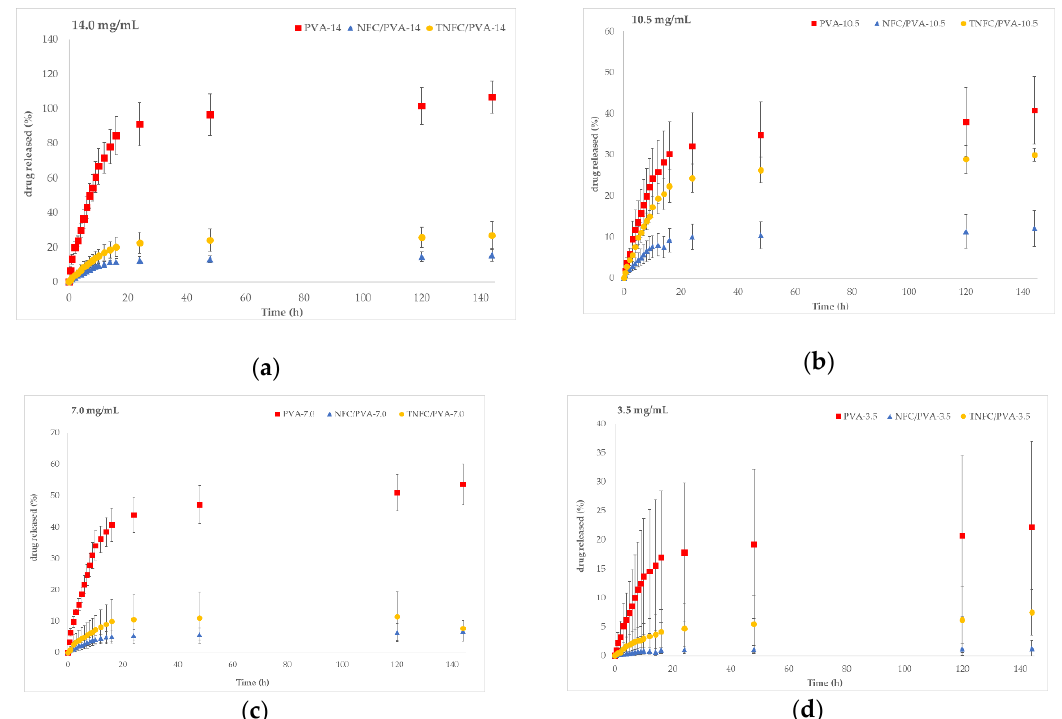
Figure 3. Comparative release profiles based on formulation (PVA (square), NFC/PVA (circle), TNFC/PVA (triangle)) for different initial acetaminophen concentrations: ( a ) 14.0 mg/mL, ( b ) 10.5 mg/mL, ( c ) 7.0 mg/mL, ( d ) 3.5